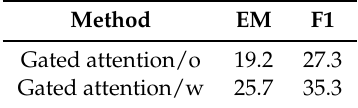
Table 7. The comparison between the model with and without gated